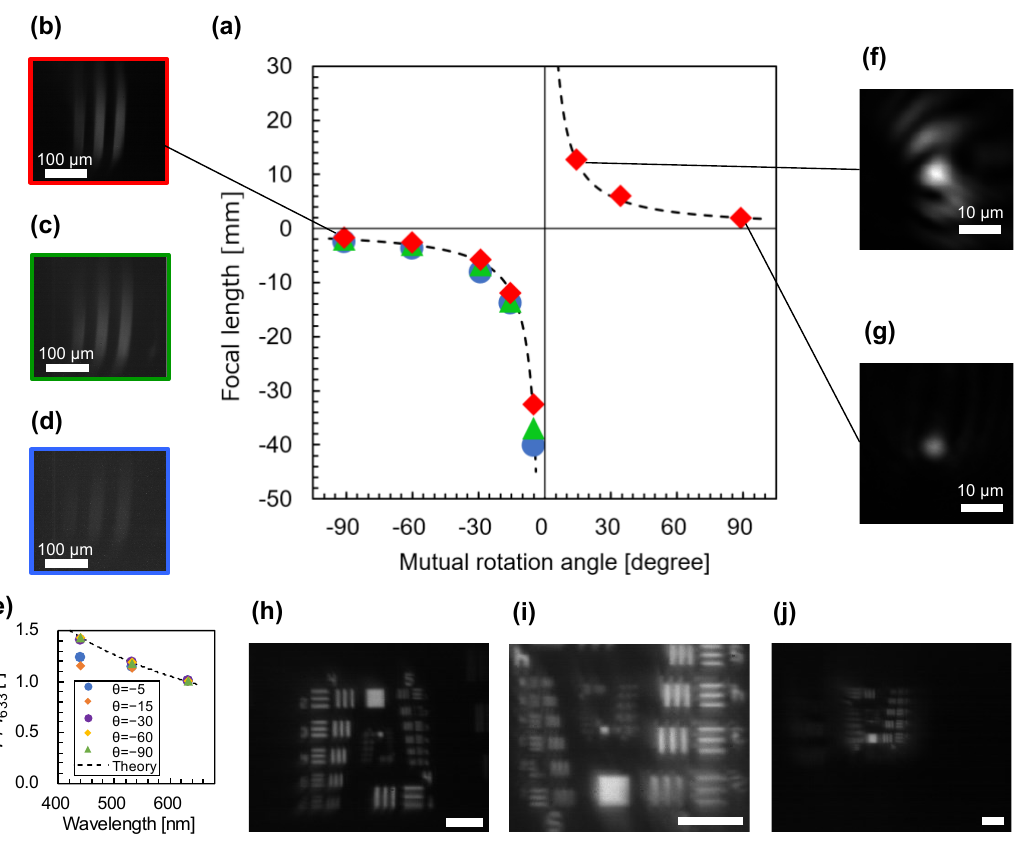
Figure 4: Measurement results. (a) Measured focal length as a function of the mutual rotation angle and (b–i) imaging results. (b–d) show images captured at the same mutual rotation angle of − 90 . 9 ◦ at wavelengths of 633, 532, and 440 nm, respectively. (e) Change in the focal length normalized to f function of the wavelength. The dashed curve shows the theoretical relationship given by Eq. (6). (f) and (g) show focal spot images captured at the mutual rotation angles of + 14 . 4 ◦ and + 88 . 9 ◦ , respectively. (h–j) show the USAF target images observed at a wavelength of 633 nm and mutual rotation angles of − 32 . 0 ◦ , + 28 . 3 ◦ , and + 88 . 5 ◦ , respectively. The scale bars in (h–j) indicate a distance of 300 μ